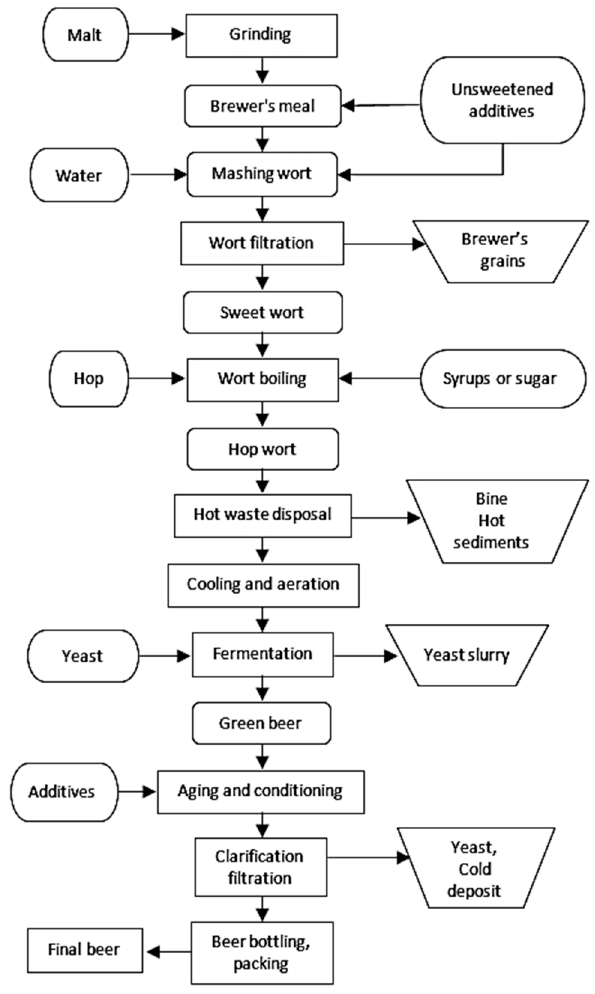
Figure 2. General scheme of beer production.